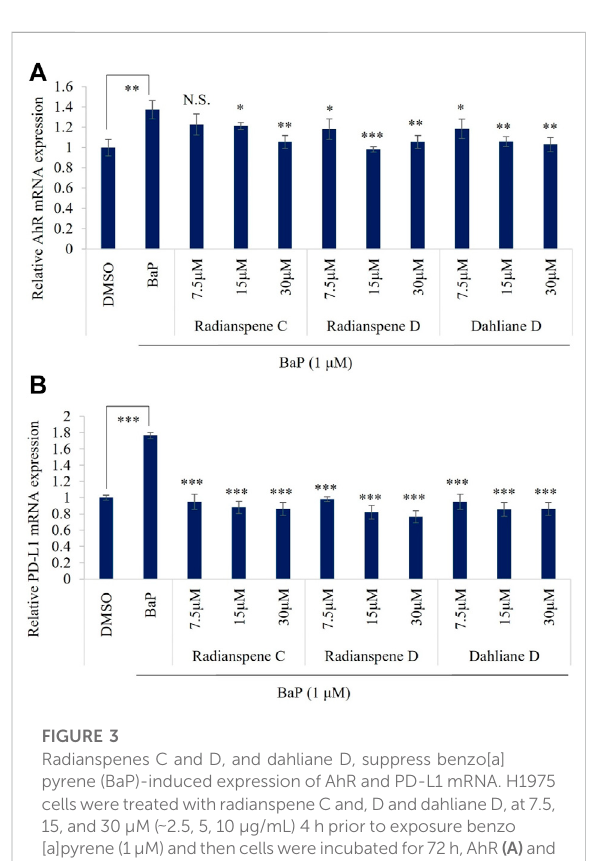
FIGURE 3 Radianspenes C and D, and dahliane D, suppress benzo[a] pyrene (BaP)-induced expression of AhR and PD-L1 mRNA. H1975 cellsweretreatedwithradianspeneCand,DanddahlianeD,at7.5, 15, and 30 µM ( (cid:1) 2.5, 5, 10 µg/mL) 4 h prior to exposure benzo [a]pyrene(1µM)andthencellswereincubatedfor72h,AhR (A) and PD-L1 (B) mRNA level was measured using qRT-PCR. * p < 0.05; ** p < 0.01; *** p < 0.001; NS, no signi fi cant difference when compared with the BaP-treated group or between indicated